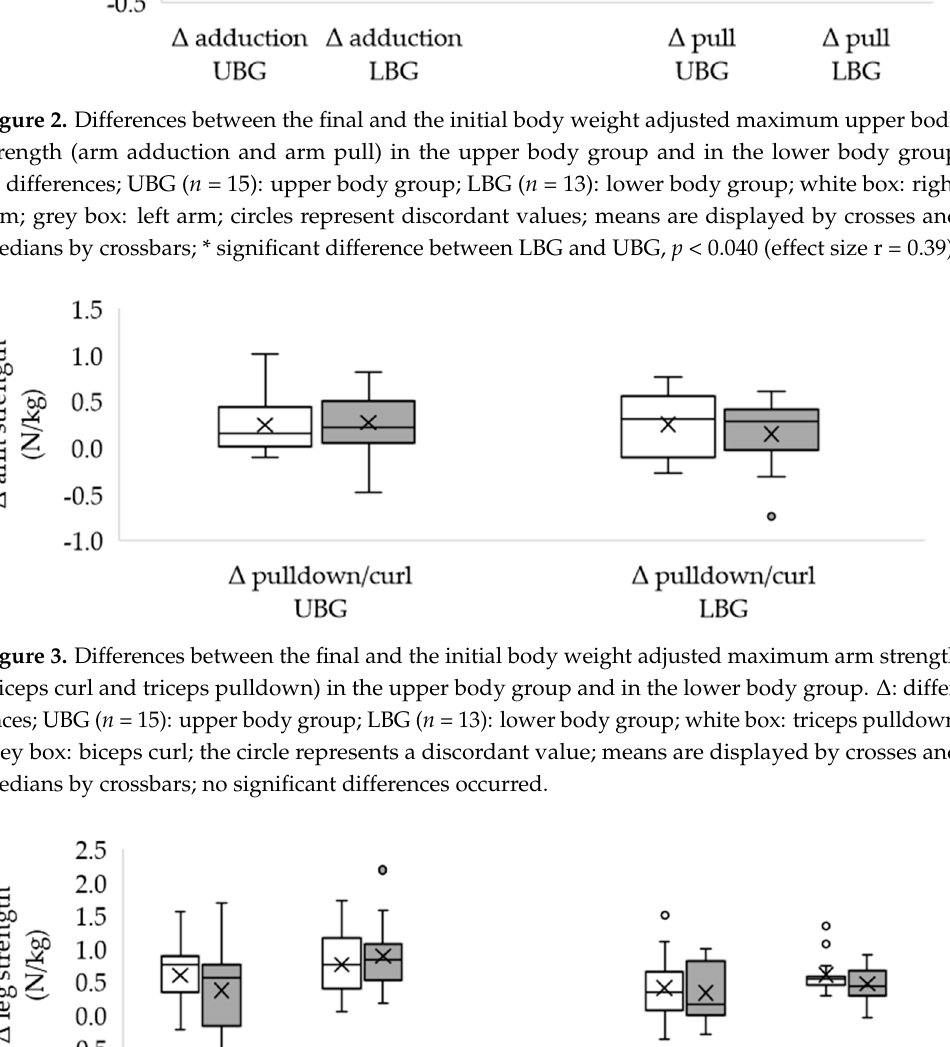
(leg extension and leg curl) in the upper body group and in the lower body group. ∆ : difference;